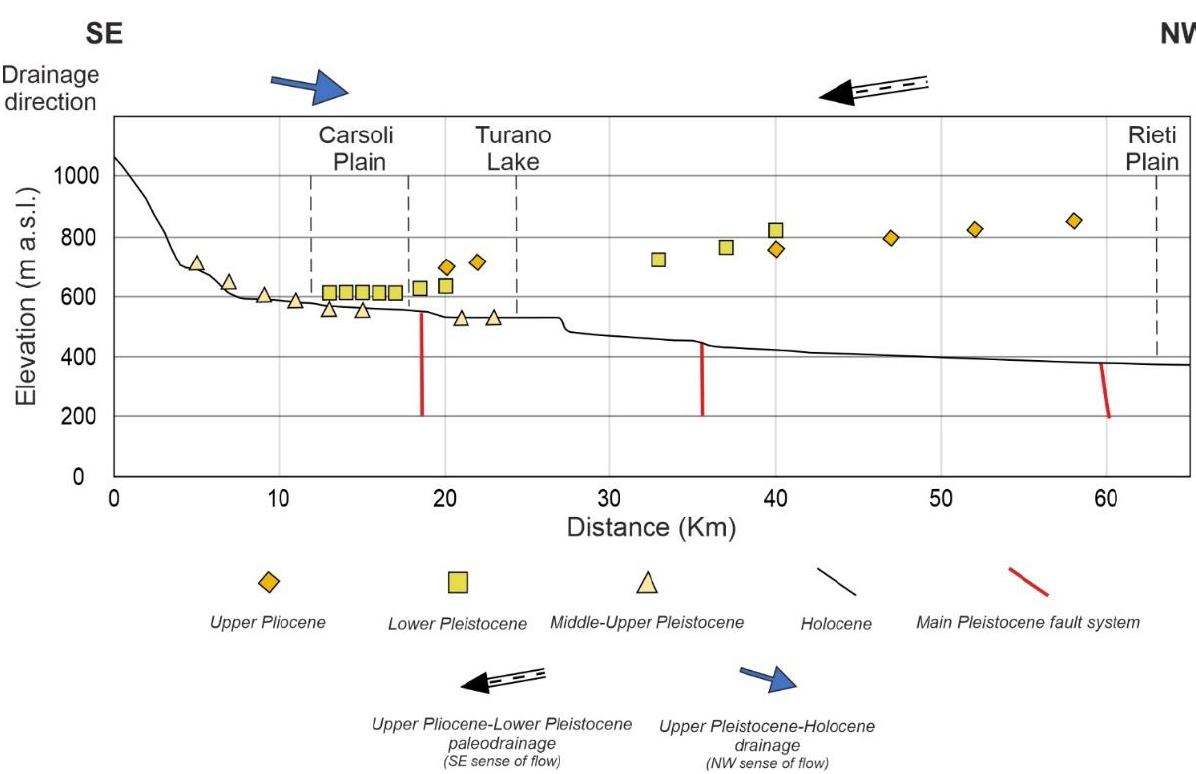
Figure 9. Generalized reconstruction of the longitudinal profile segment of the Turano River and its continental deposits. This simplified reconstruction was performed plotting the spatial arrangement of continental deposits from the uppermost stream, near Mt. Tarino (see also Figure 4), to the Velino River junction, within the Rieti Plain.